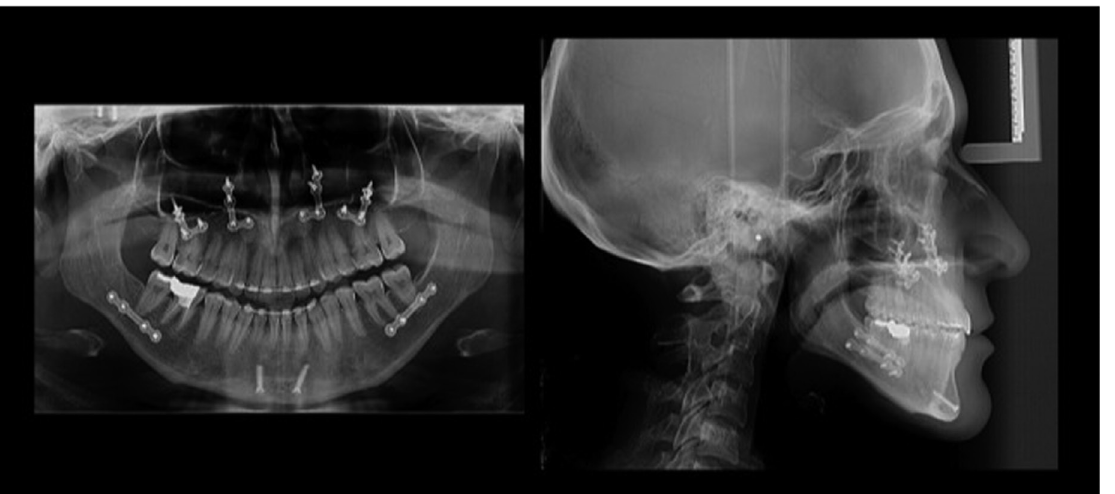
Figure 14. Panoramic and lateral cephalometric radiographs at one-year follow-up.